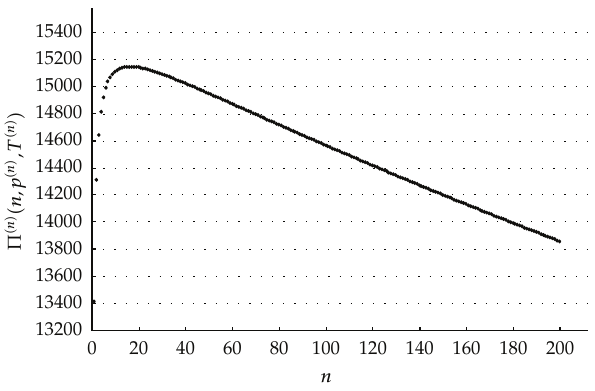
Figure 3: The optimal total profit per unit time for n (cid:8) 1 , 2 ,..., 200.